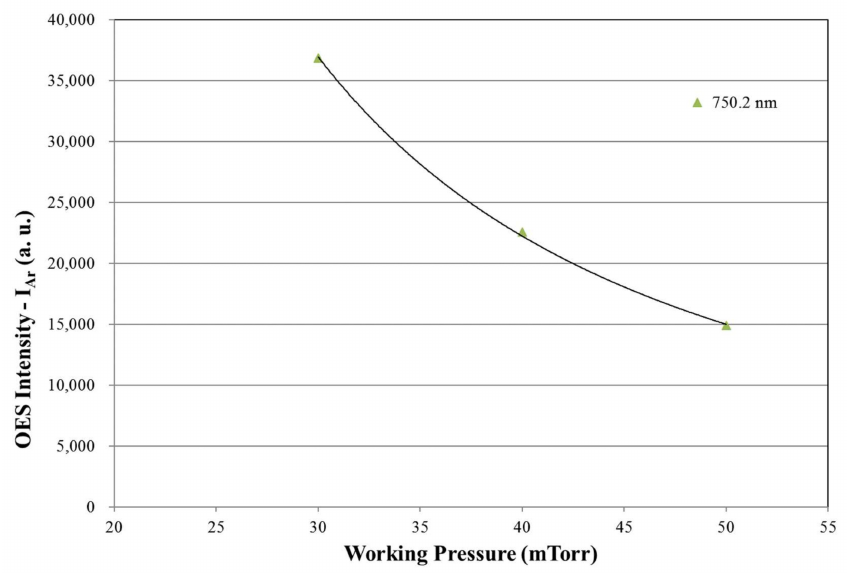
Figure 11. OES intensity of Ar vs. working pressure. The Ar peak appears at 750.2